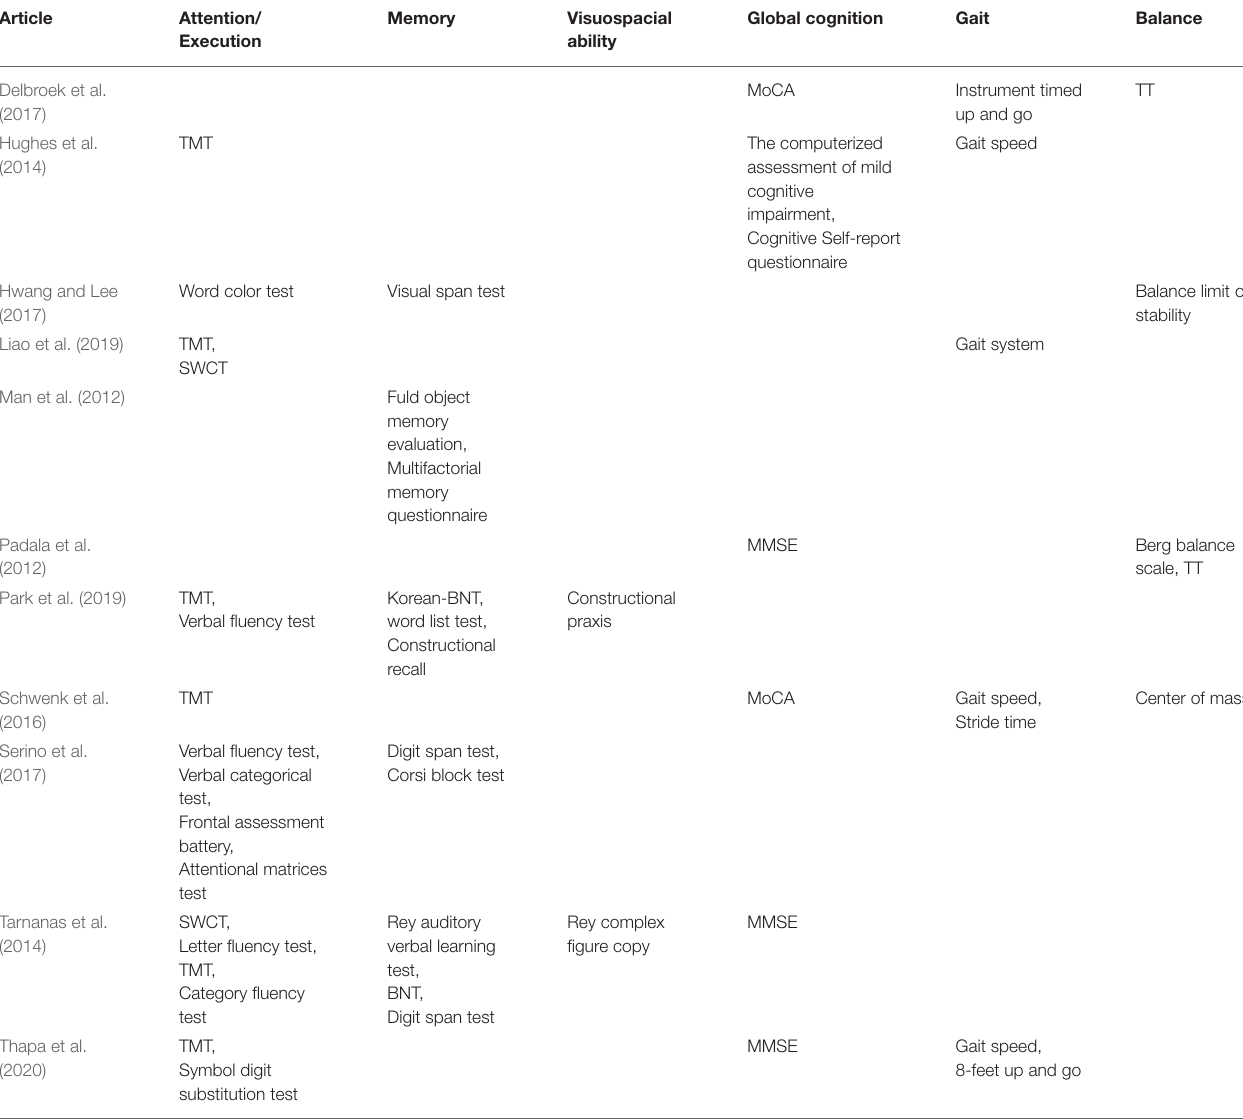
TABLE 3 | Outcome measures used in the included